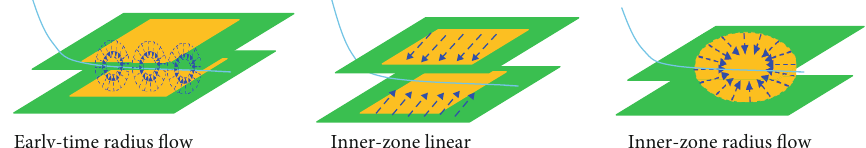
Figure 5: Schemata of typical fl ow regimes.